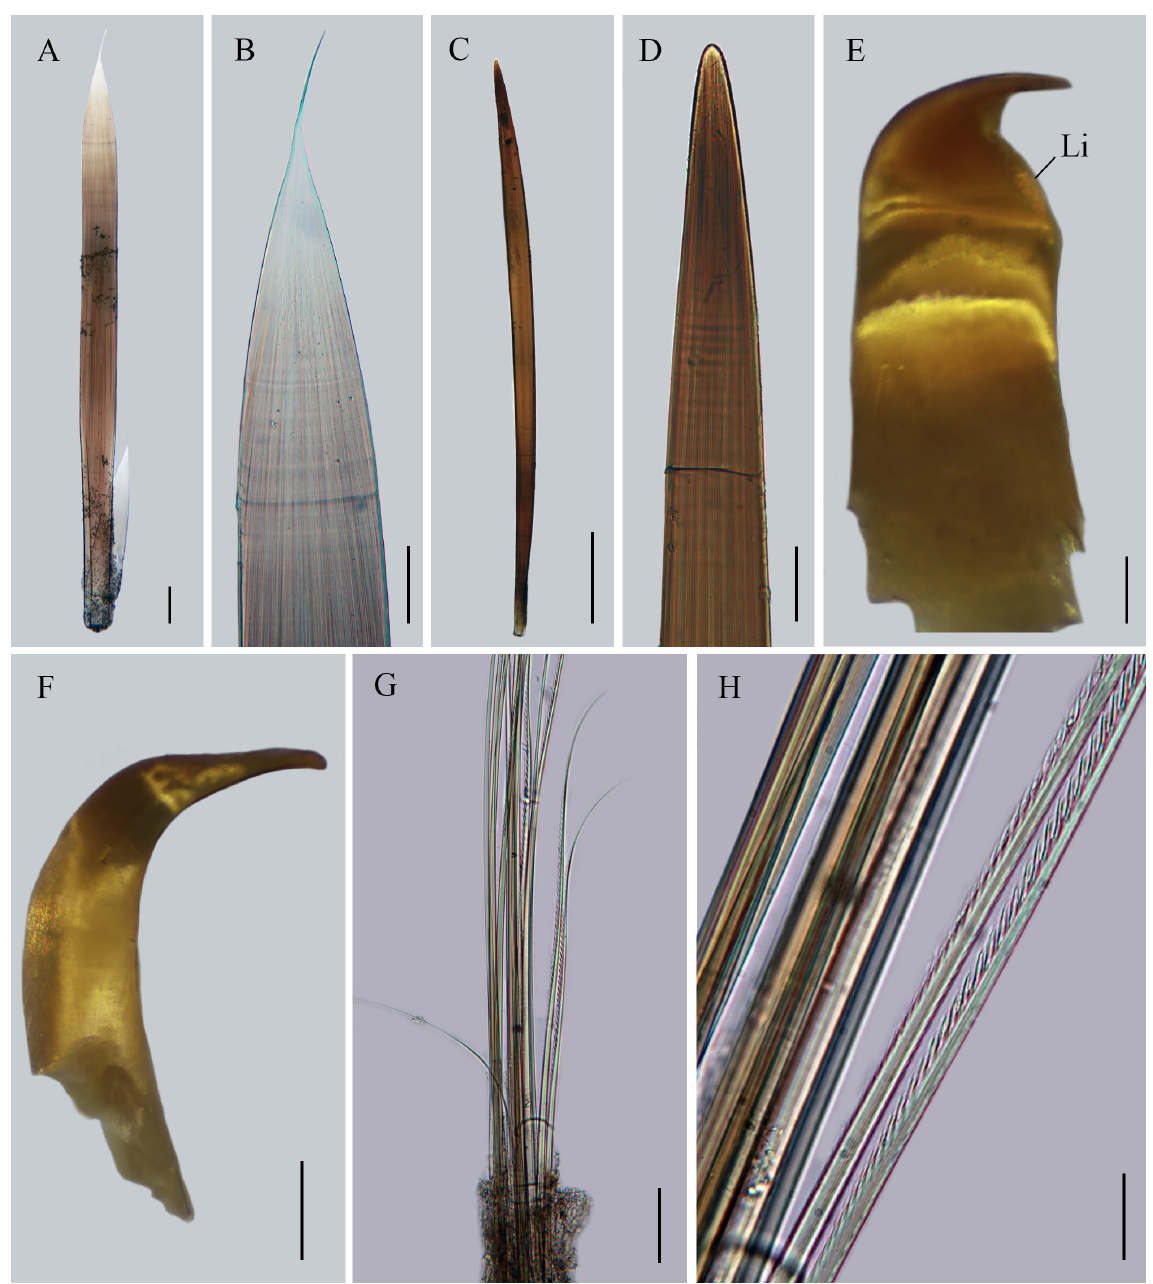
Fig. 19. Tetreres israeli sp. nov., holotype (UMML-22.1195). A . Outer palea. B . Tip of outer palea. C . Inner palea. D . Tip of inner palea. E . Nuchal hook, ventral view. F . Nuchal hook, lateral view. G . Abdominal parapodium. H . Abdominal chaetae. Abbreviation = Li, limbation. Scale bars: A, E = 200 µm; B, D, G = 100 µm; C = 1 mm; F = 0.5 mm; H = 30